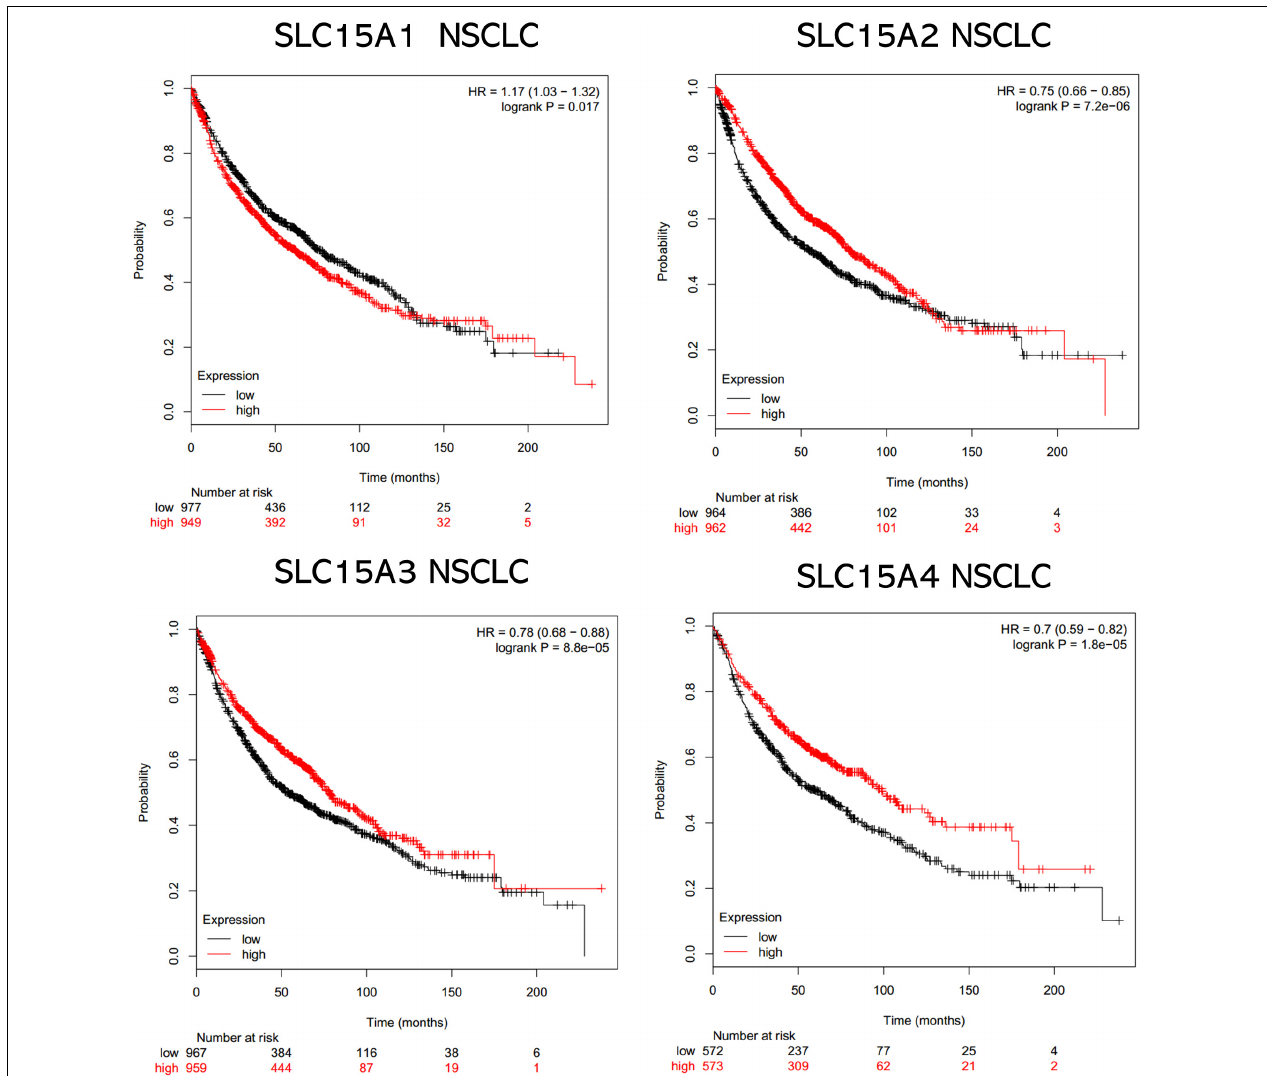
FIGURE 3 | The prognostic values of the SLC15A family members in NSCLC. A log rank p value < 0.05 was considered statistically significant. The median expression level was set as the cutoff for the KM plot. The red line indicates high expression, and the blue line indicates low expression. NSCLC, non-small-cell lung